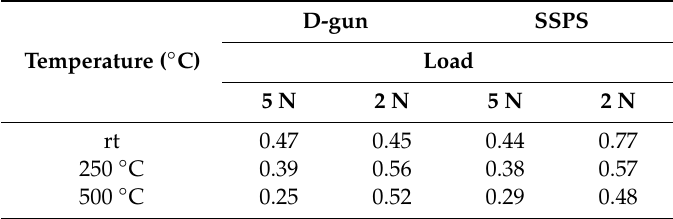
Table 4. Volume losses of the samples at varying load and temperature conditions of D-gun and SSPS coating technique. Room